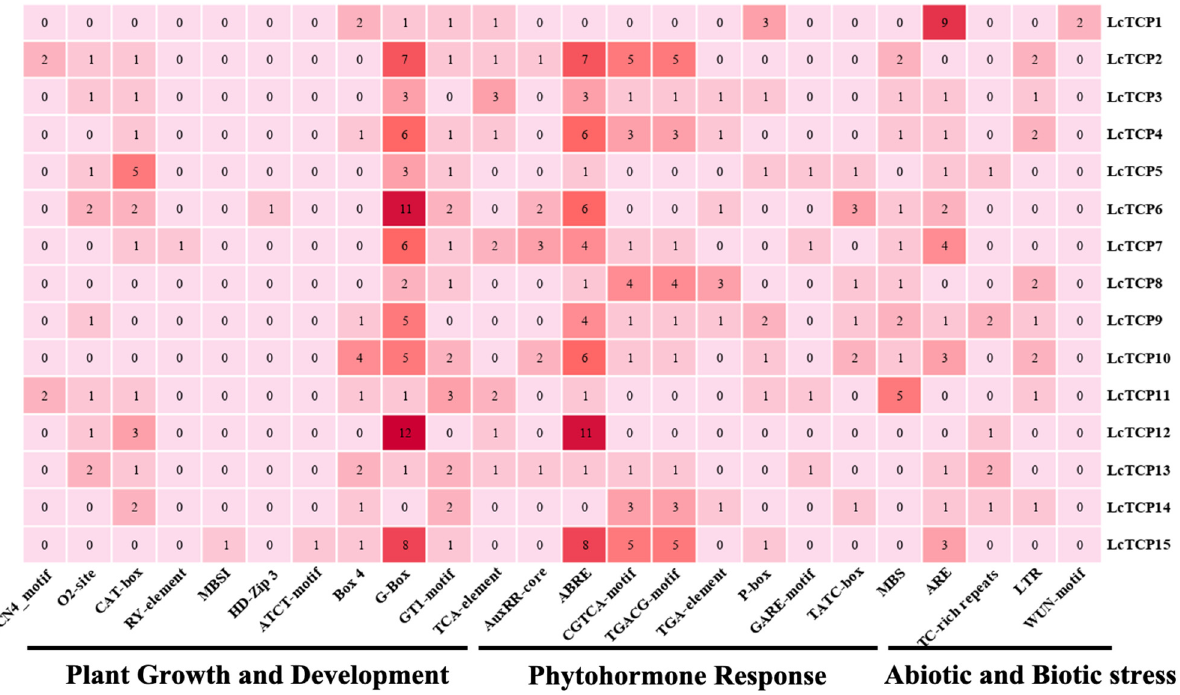
Figure 5. The identified putative Cis-Elements in the Promoters of L. chinense TCP genes are repre- sented by varying numbers shaded in red within cells of LcTCP genes on the y -axis and response factors on the x -axis.